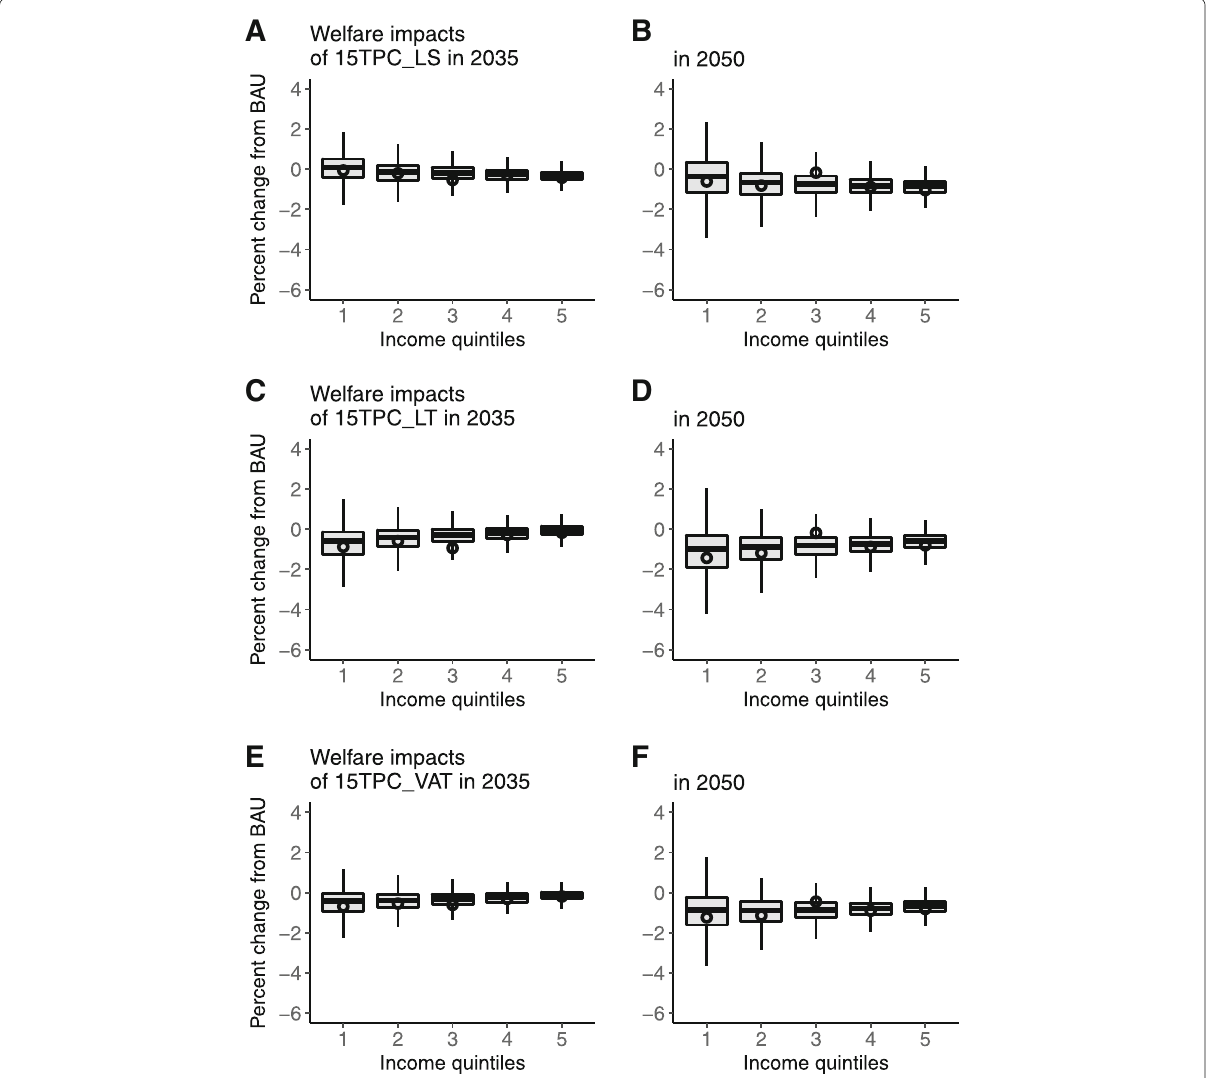
Fig. 2 Distribution of welfare impacts across income quintiles for different revenue recycling schemes (15TPC target) in 2035 ( a , c , and e ) and 2050 ( b , d , and f